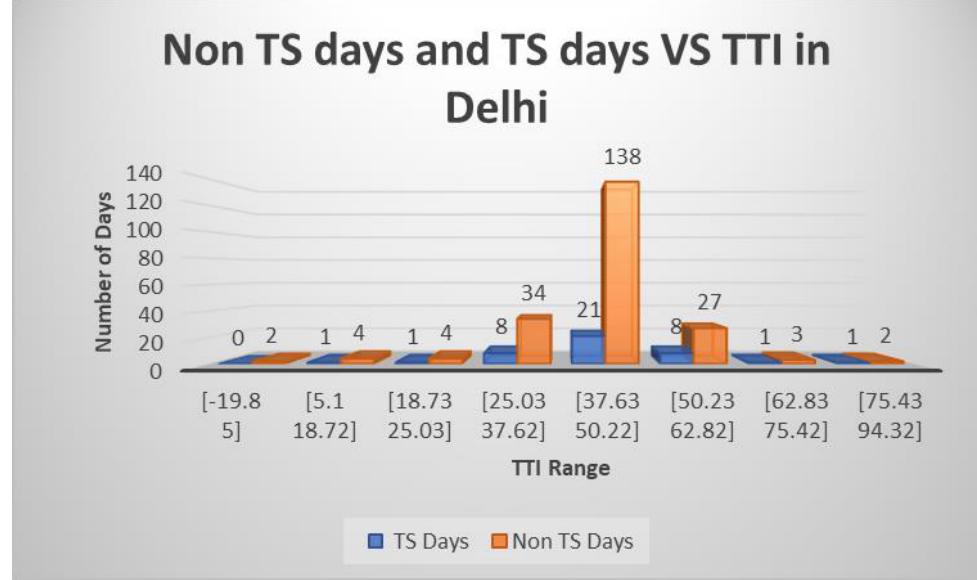
Figure 3. The figure shows the distribution of thunderstorm and non-thunderstorm days in the given SI range over Delhi. As can be seen here, thunderstorms are prominent between the SI range of 37.6 and